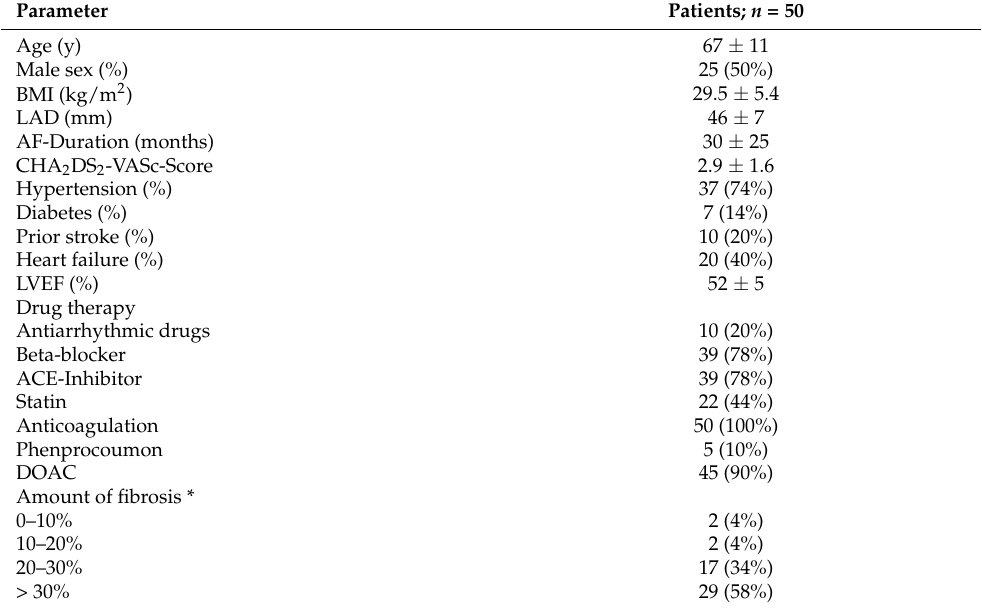
Table 1. Patient characteristics (LAD, left atrial diameter; AF, atrial fibrillation; LVEF, left ventricular ejection fraction; DOAC, direct oral anticoagulation). * Left atrial fibrosis was measured using the area measurement tool based on bipolar